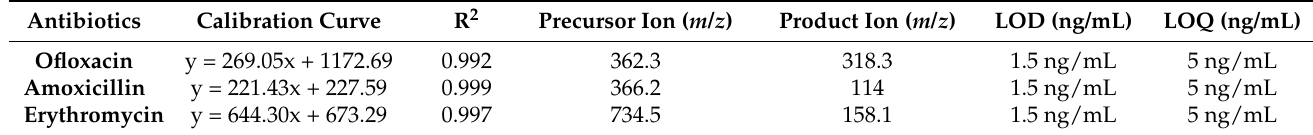
Table 2. Mass transitions (UPLC-MS) of antibiotics in river water of the Yamuna. Antibiotics Calibration